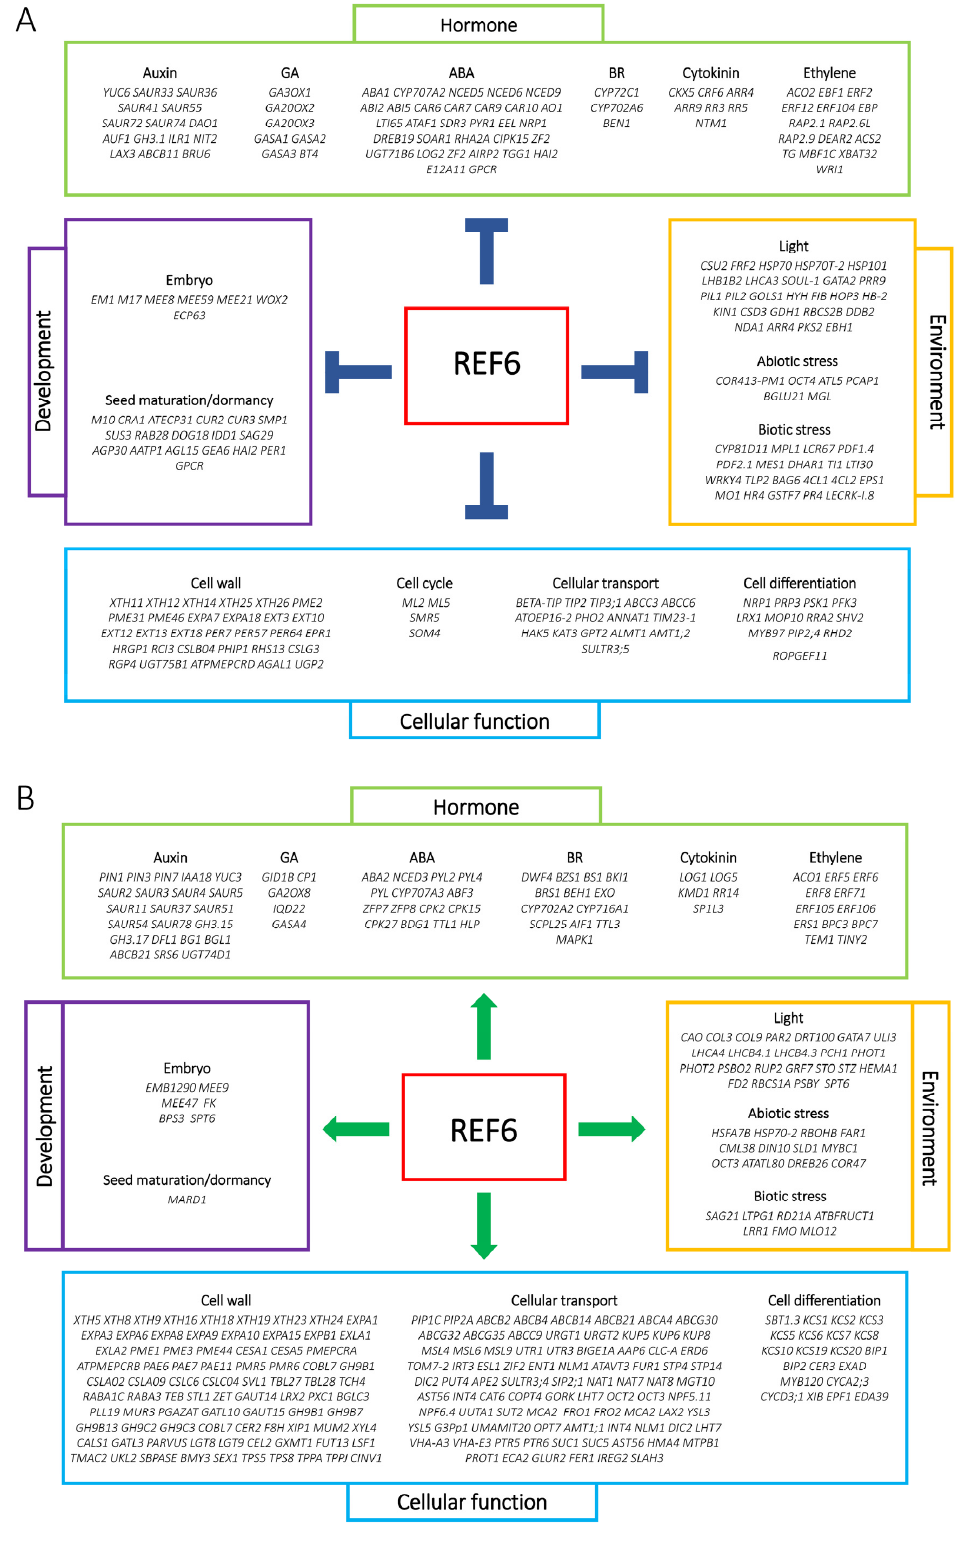
Figure 4. REF6 activated and repressed genes in imbibed seeds under FR/R conditions. ( A ) A chart displaying REF6-activated genes. ( B ) A chart displaying REF6-repressed